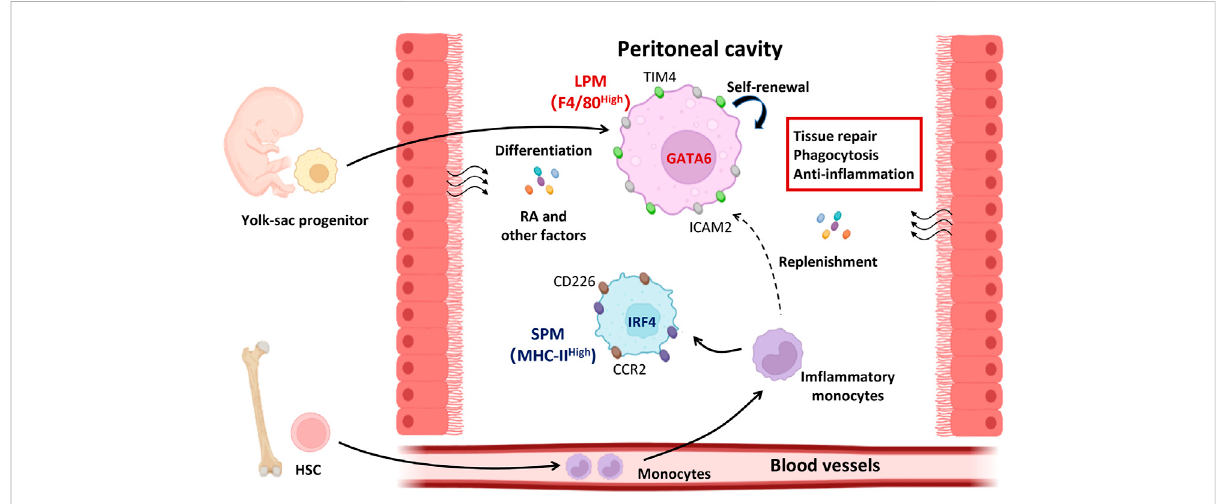
FIGURE 1 The determinants ofperitoneal residentmacrophage differentiation. Understeady state,both LPMsand SPMs represent theperitonealresident macrophages. LPMs are dominant in the peritoneal cavity and function in tissue repair, phagocytosis, and anti-in fl ammation. LPMs are differentiated from the yolk-sac progenitors and maintain their numbers by self-renewal. Local environment supports the LPMs differentiation by secreting the retinoicacidandotherfactors.DifferentfromLPMs,SPMsaredifferentiatedfromHSCderivedmonocytesandexpandthemselvesinperitoneal cavity once in fl ammation occurs. The differentiation of LPMs is mediated by transcriptional factor GATA6 while that of SPMs is IRF4. GATA6, GATA bindingproteinsix;HSC,hematopoieticstemcells;IRF4,interferonregulatoryfactor4;LPMs,largeperitonealmacrophages;RA,retinoicacid;SPMs, small peritoneal